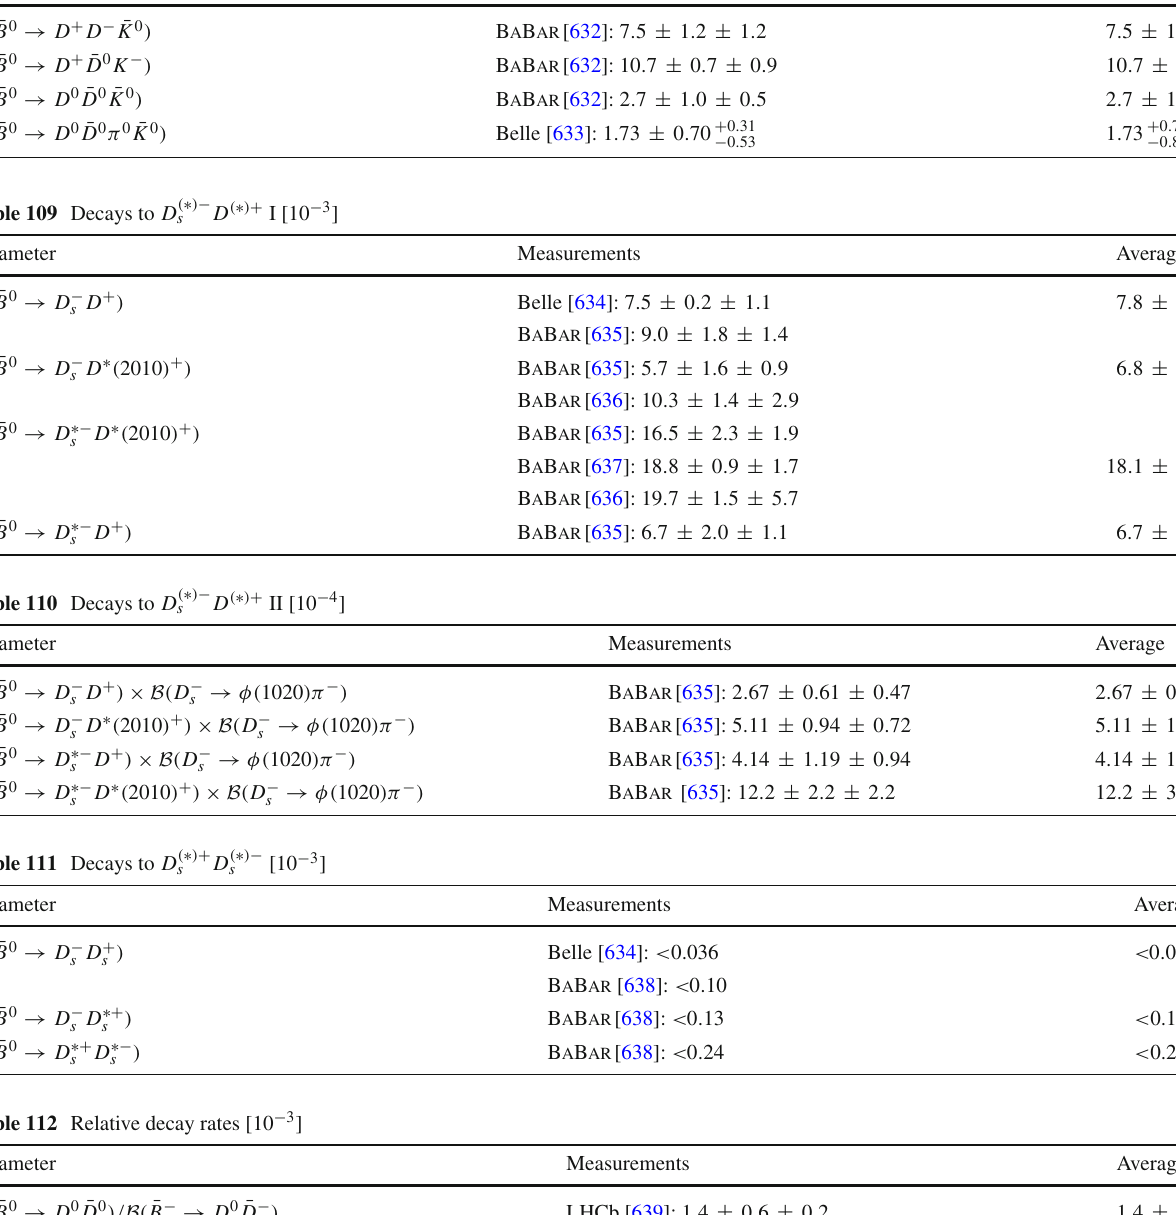
Table 108 Decays to two D mesons and a kaon II [ 10 − 4 ] Parameter Measurements